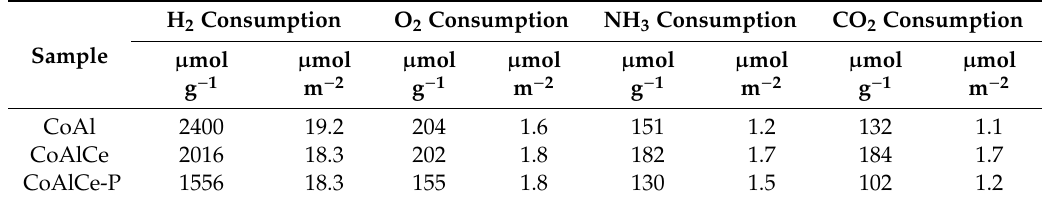
Table 3. Consumption of H 2 , O 2 , NH 3 and CO 2 in H 2 -TPR, TPO, NH 3 -TPD and CO 2 -TPD